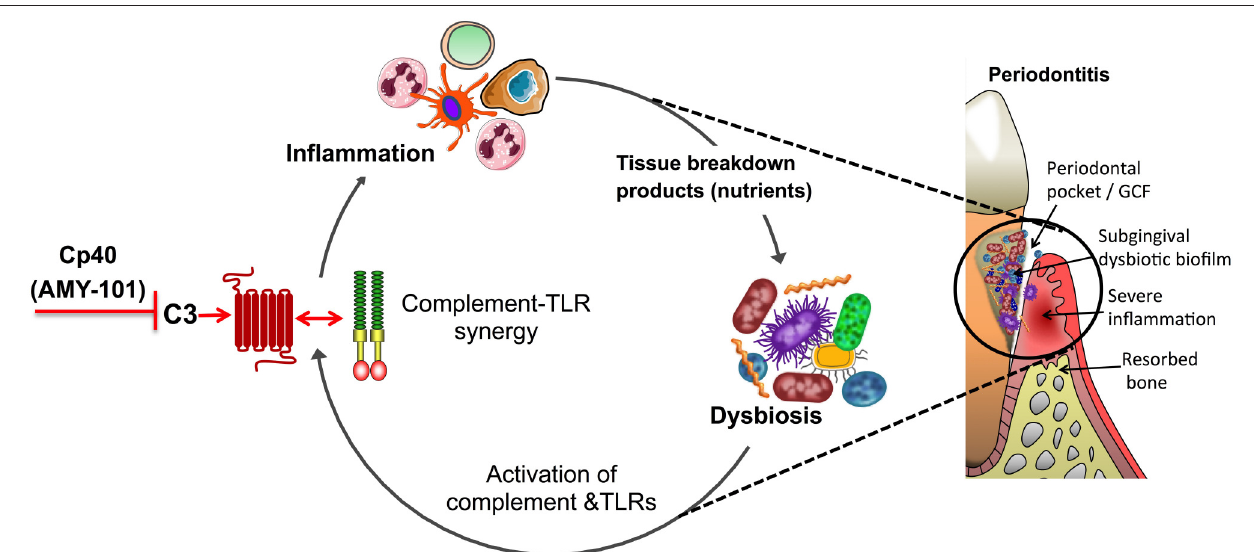
FIGURE 3 | Complement-targeted inhibition blocks a vicious cycle linking destructive inflammation and dysbiosis in periodontitis. Periodontitis is driven by a reciprocally reinforced interplay between dysbiotic microbial communities and inflammation. Whereas, dysbiosis induces inflammation, the nutritionally favorable inflammatory environment is a major ecological factor that exacerbates dysbiosis. Studies in different preclinical models showed that complement inhibition abrogates complement-TLR crosstalk signaling and resulting inflammation, thereby breaking the disease-provoking vicious cycle regardless of the presence of intact TLR signaling. For instance, blocking the central complement component C3 through the use of the peptidic compound Cp40/AMY-101 has blocked experimental or naturally occurring periodontitis in non-human